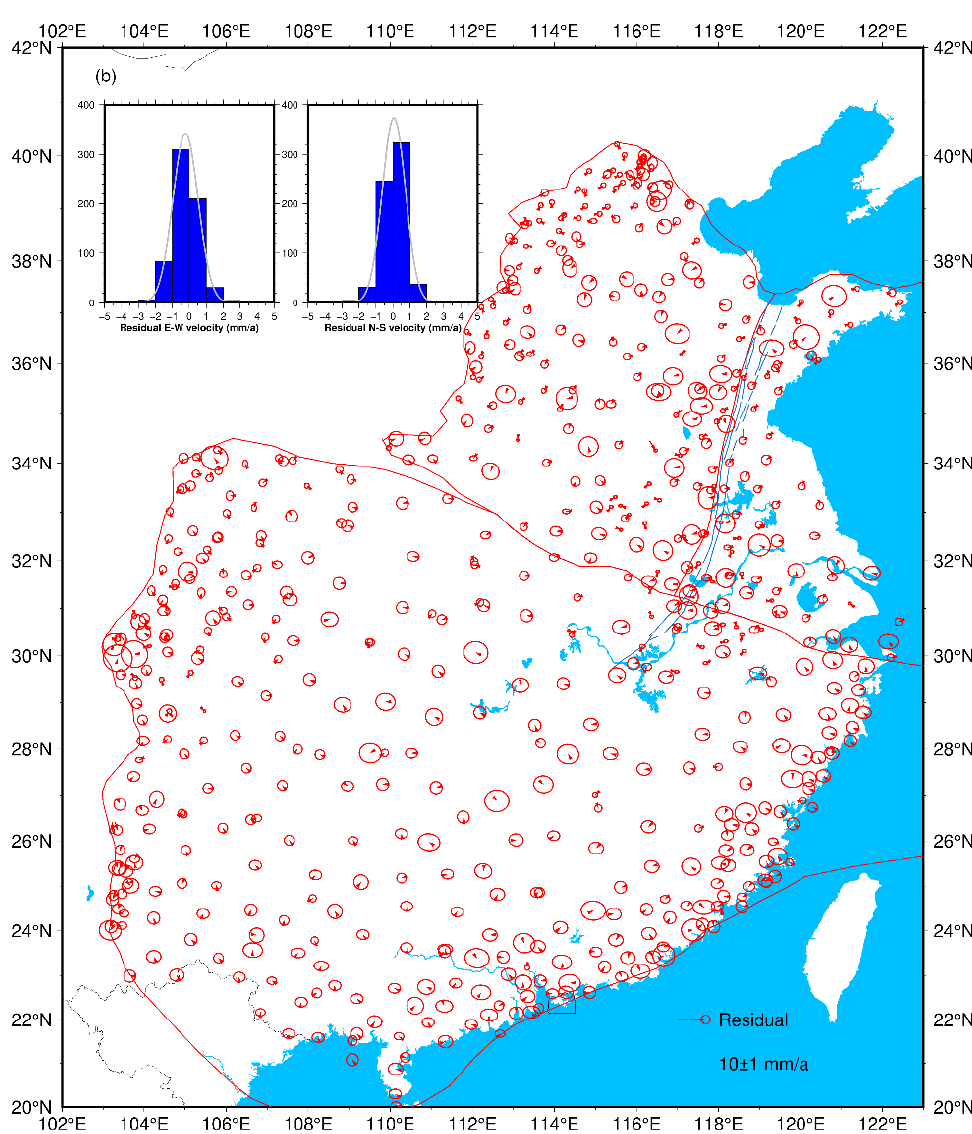
Figure 3. Comparison between observed and predicted GPS velocity field ( a ). Black and red arrows are observed velocity and predicted velocity, respectively. GPS velocity residuals distribution for the optimal model ( b ). The images in the upper left corner are the statistical histogram of residuals of the east components and north components, respectively.